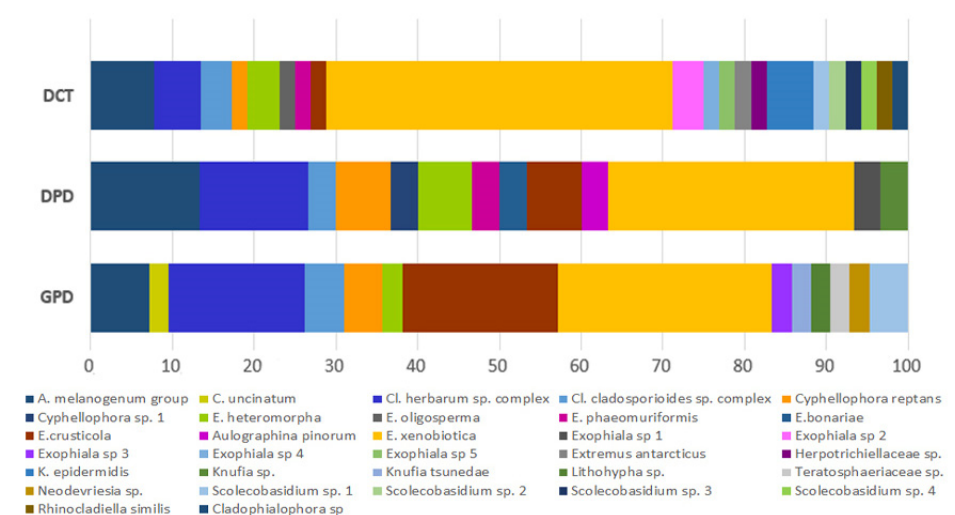
Figure 5. Relative abundance of the cultivable black fungal diversity recorded in diesel car tanks (DCT), diesel pump dispensers (DPD), and gasoline pump dispensers (GPD). The relative abundance is expressed as percentage (x axis).